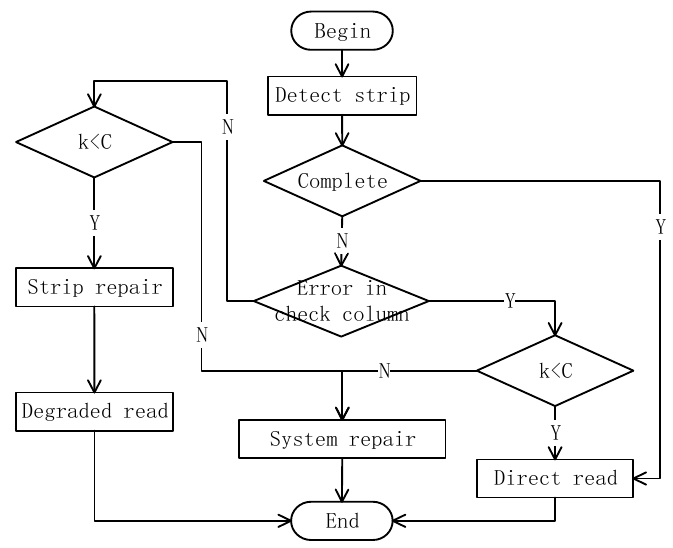
Figure 3. Repair Trigger Mechanism. Figure 5. Repair Trigger